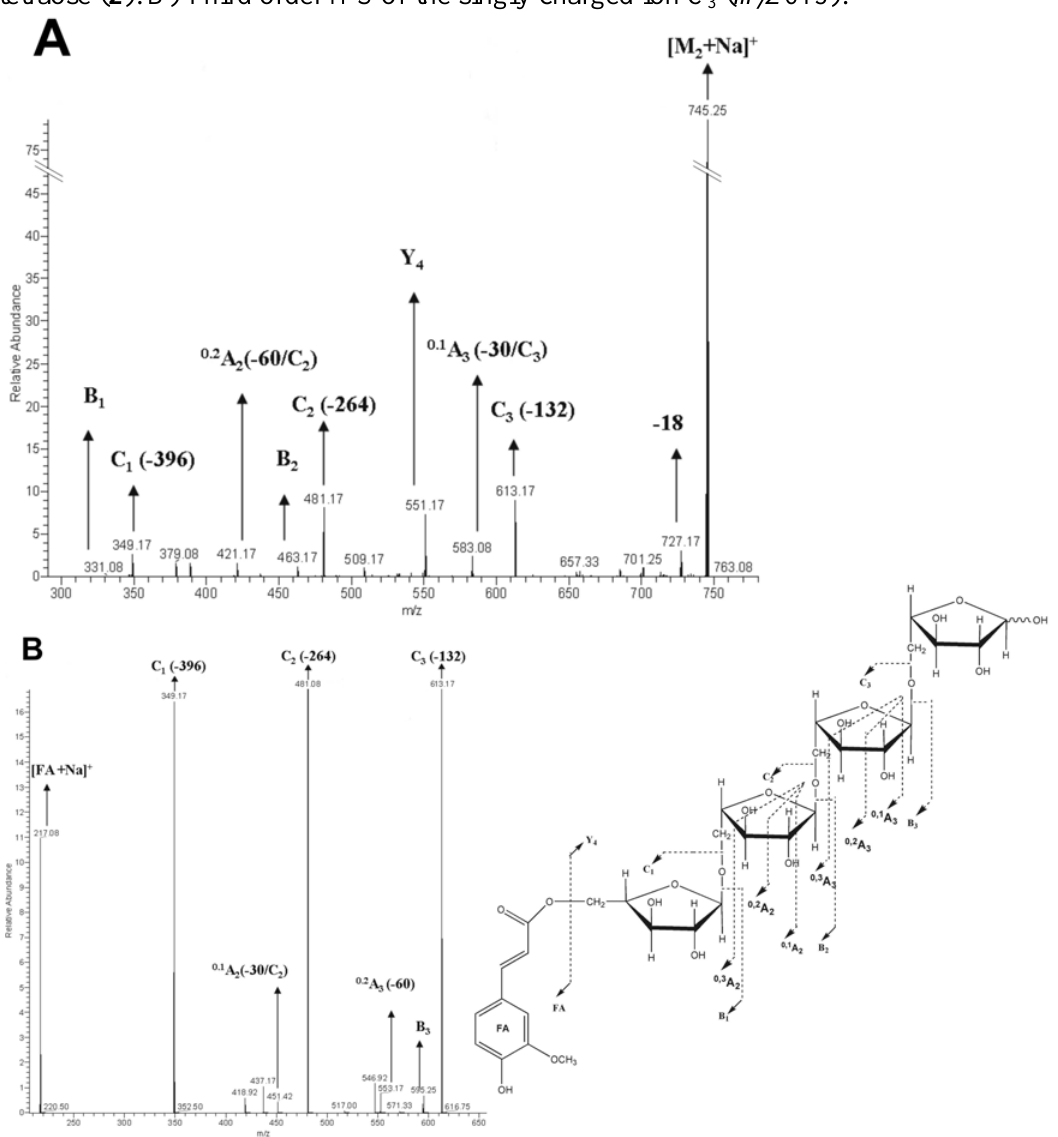
+ Na] + ( m/z 745) of 2